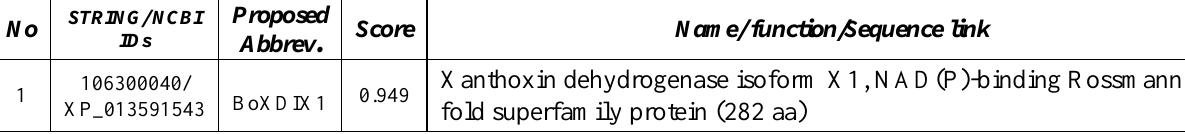
Table 2. Predicted Interactome partners and their functions base of KEGG